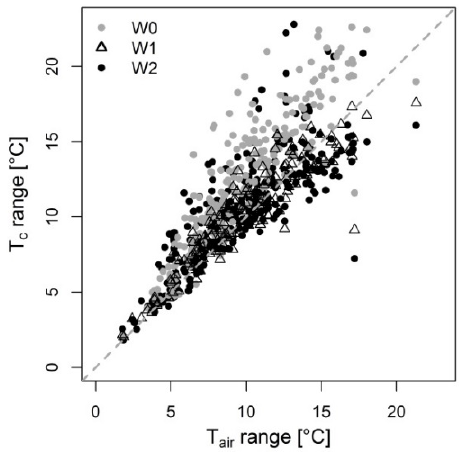
Figure 4. Scatter plot of the daily range of canopy temperatures (T c , hourly values) and air temperatures (T air , hourly values) for the complete observation period and for all irrigation treatments (W0 = no irrigation, W1 = medium deficit irrigation and W2 = full irrigation).